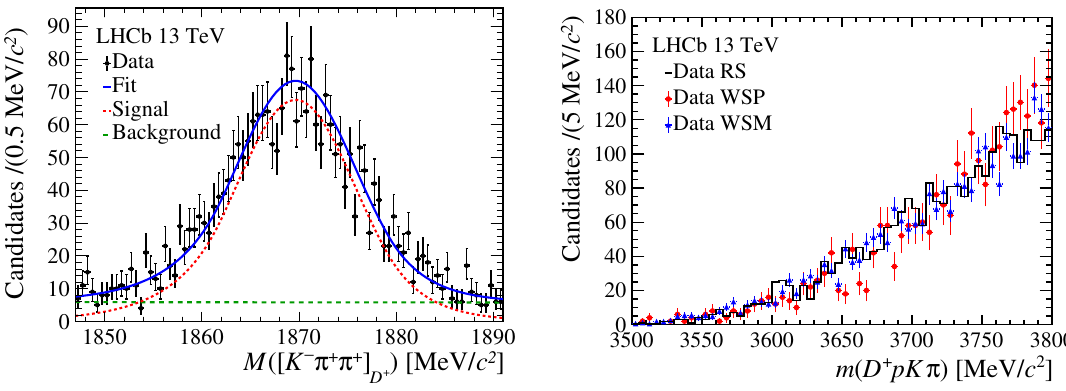
Figure 2 . (Left) Invariant-mass distribution of the D + candidates after the full selection. The black points represent data and the (cid:12)t is indicated by the continuous (blue) line with the individual signal and background components represented by the dotted (red) line and dashed (green) line, respectively. (Right) Invariant-mass distributions of right-sign (black) D + pK (cid:0) (cid:25) + , wrong-sign- plus (red) D + pK + (cid:25) + and wrong-sign-minus (blue) D + pK (cid:0) (cid:25) (cid:0) data combinations are shown. The control samples have been normalised to the right-sign